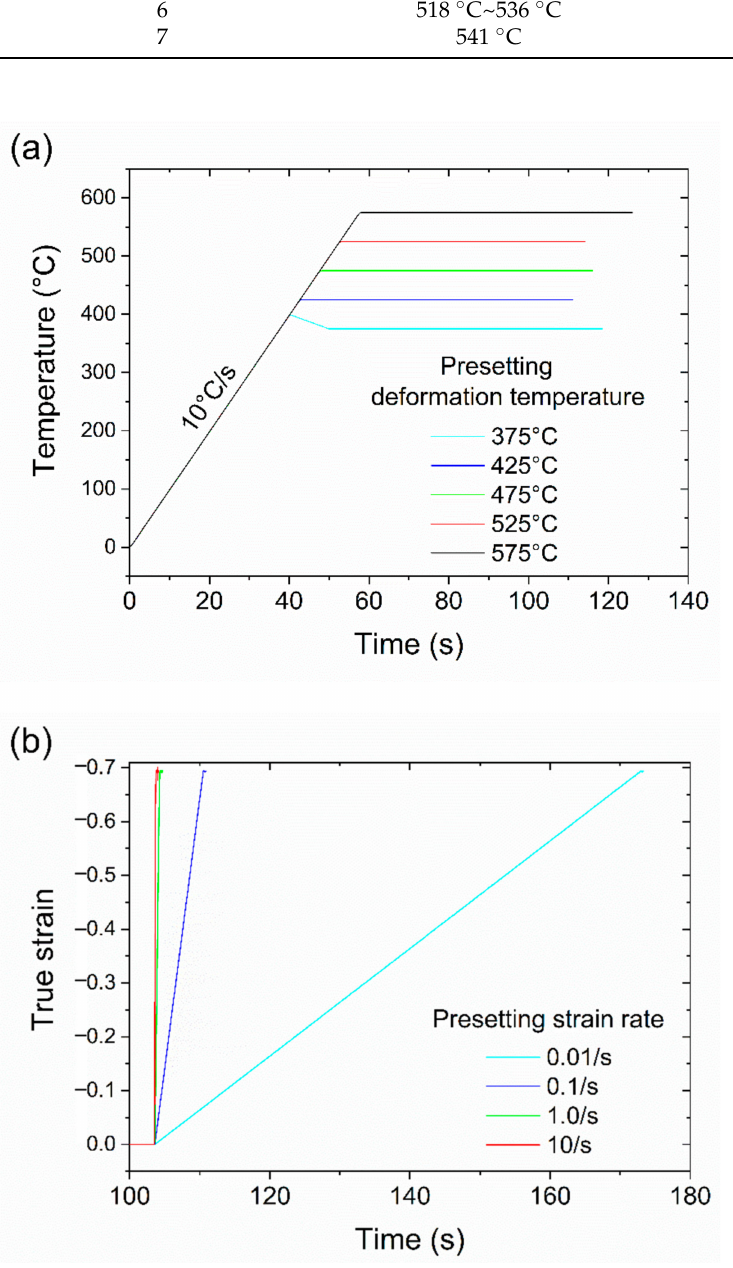
Figure 2. Thermomechanical history during the hot compression tests. ( a ) Temperature history; ( b ) strain